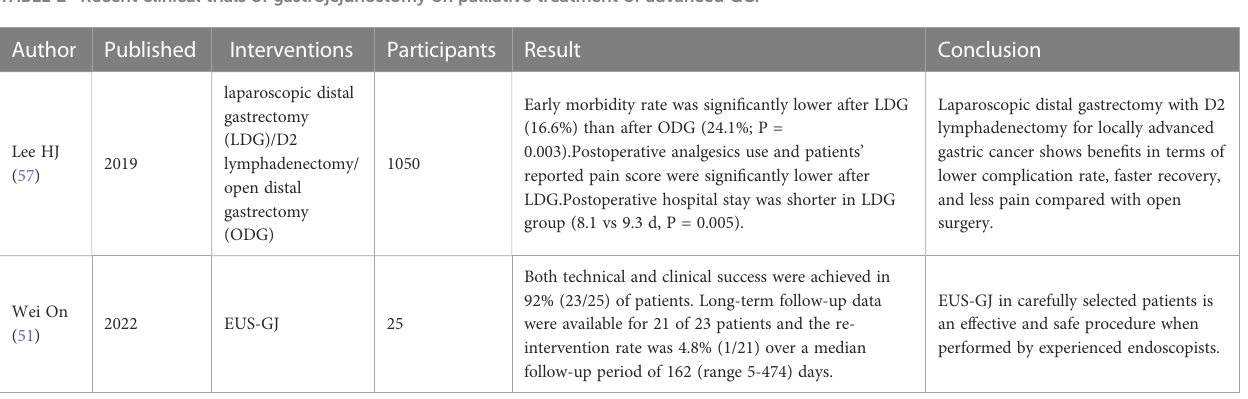
TABLE 2 Recent clinical trials of gastrojejunostomy on palliative treatment of advanced